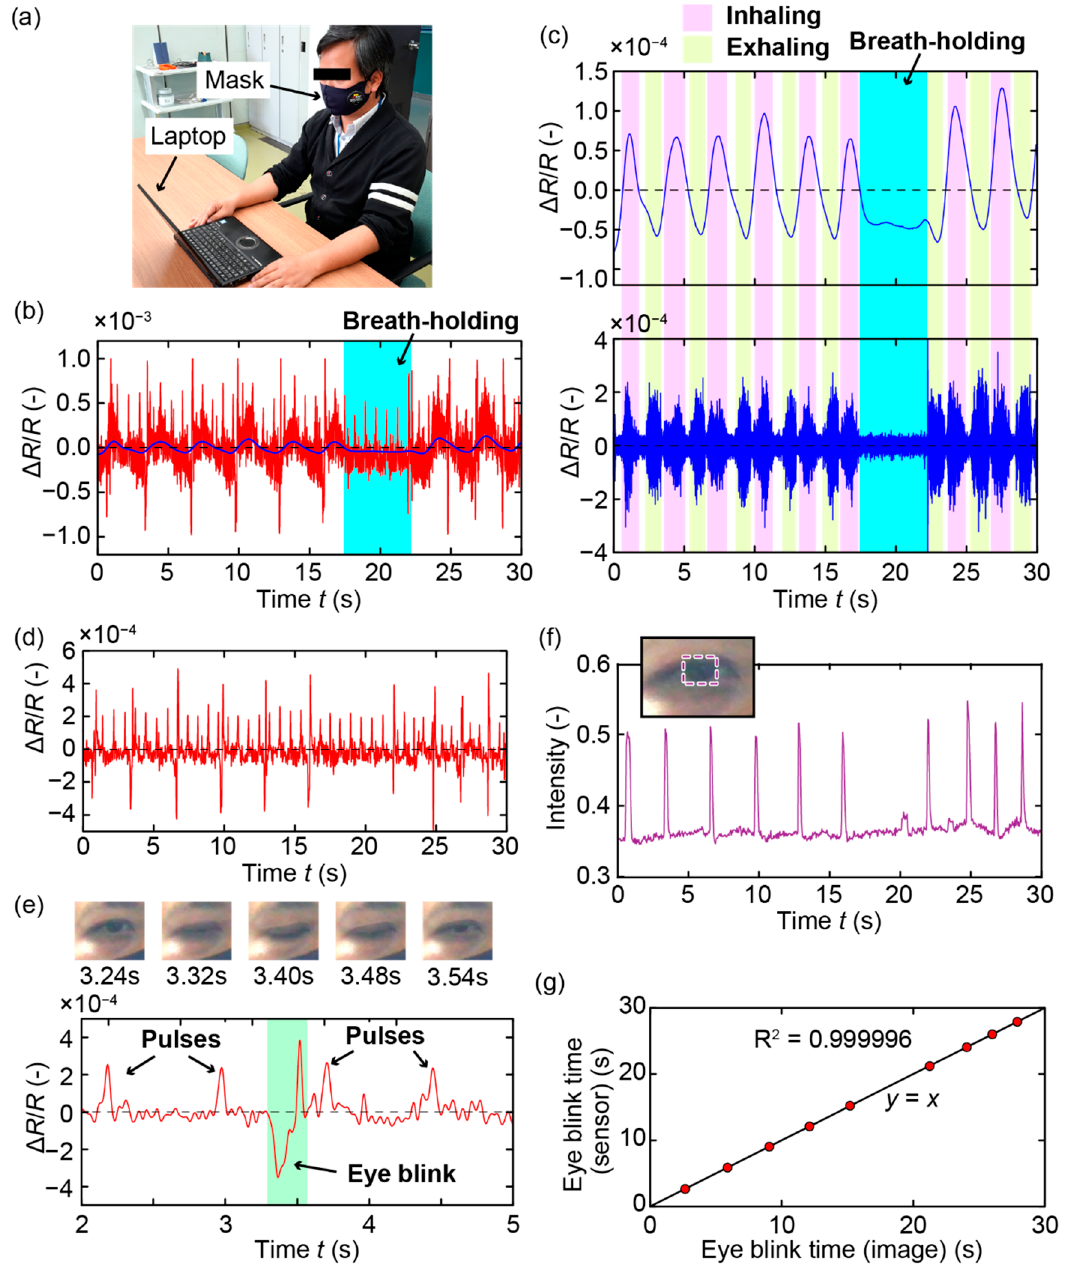
Figure 4. Measurement results in the case of nose breathing. ( a ) Photograph of the measurement setup. ( b ) Sensor raw data (red) and low-pass-filtered data (blue). ( c ) Low- and high-pass-filtered signals showing the respiration of the subject. ( d ) Processed signal showing the pulse and eye blinks of the subject. ( e ) Zoomed-in view of the signal shown in ( d ) and images of the camera showing one eye blinks of the subject. ( f ) Eye blinks of the subject detected from the recorded images. ( g ) Comparison between the timings of the eye blinks obtained from the sensor signal and those obtained from the